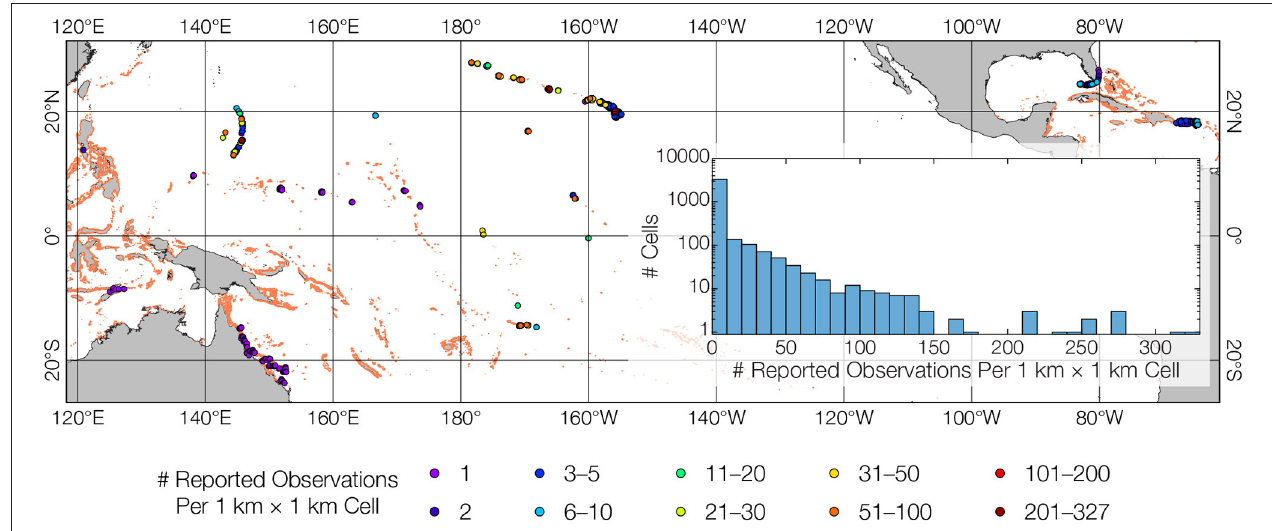
FIGURE 2 | Spatially sparse and methodologically nonuniform in-water surveys. Readily available, publicly downloadable reef survey data highlight the current data paucity paradigm within reefs and across regions. The dataset bins 32,887 scattered observations into 1 × 1km grid cells. Colored dots indicate number of observations in grid cells (higher numbers overlay lower numbers). Inset shows histogram for observations cell − 1 ; note log scale for vertical axis. Of 3,875 cells, 60.7% comprise only a single observation, 83.3% have ≤ 5 observations, only 9.1% have ≥ 20 observations. Some observations presented as single values are actually averages of several underlying data points (e.g., Australian Institute of Marine Science data for the Great Barrier Reef), while other observations require computation of benthic cover from raw counts (e.g., most NOAA data for Pacific islands). This compounds the fundamental issue that data from different regions are acquired using different methods for different purposes. These are major hinderances for regional and global reef